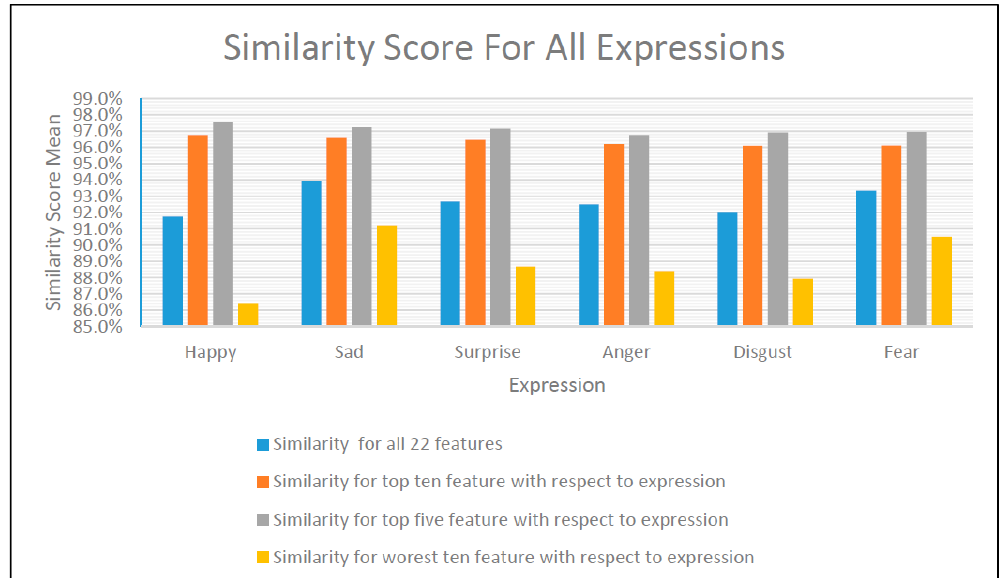
Figure 20. The similarity score (SS) for all six-expression using all features, top five, top ten, worst ten.